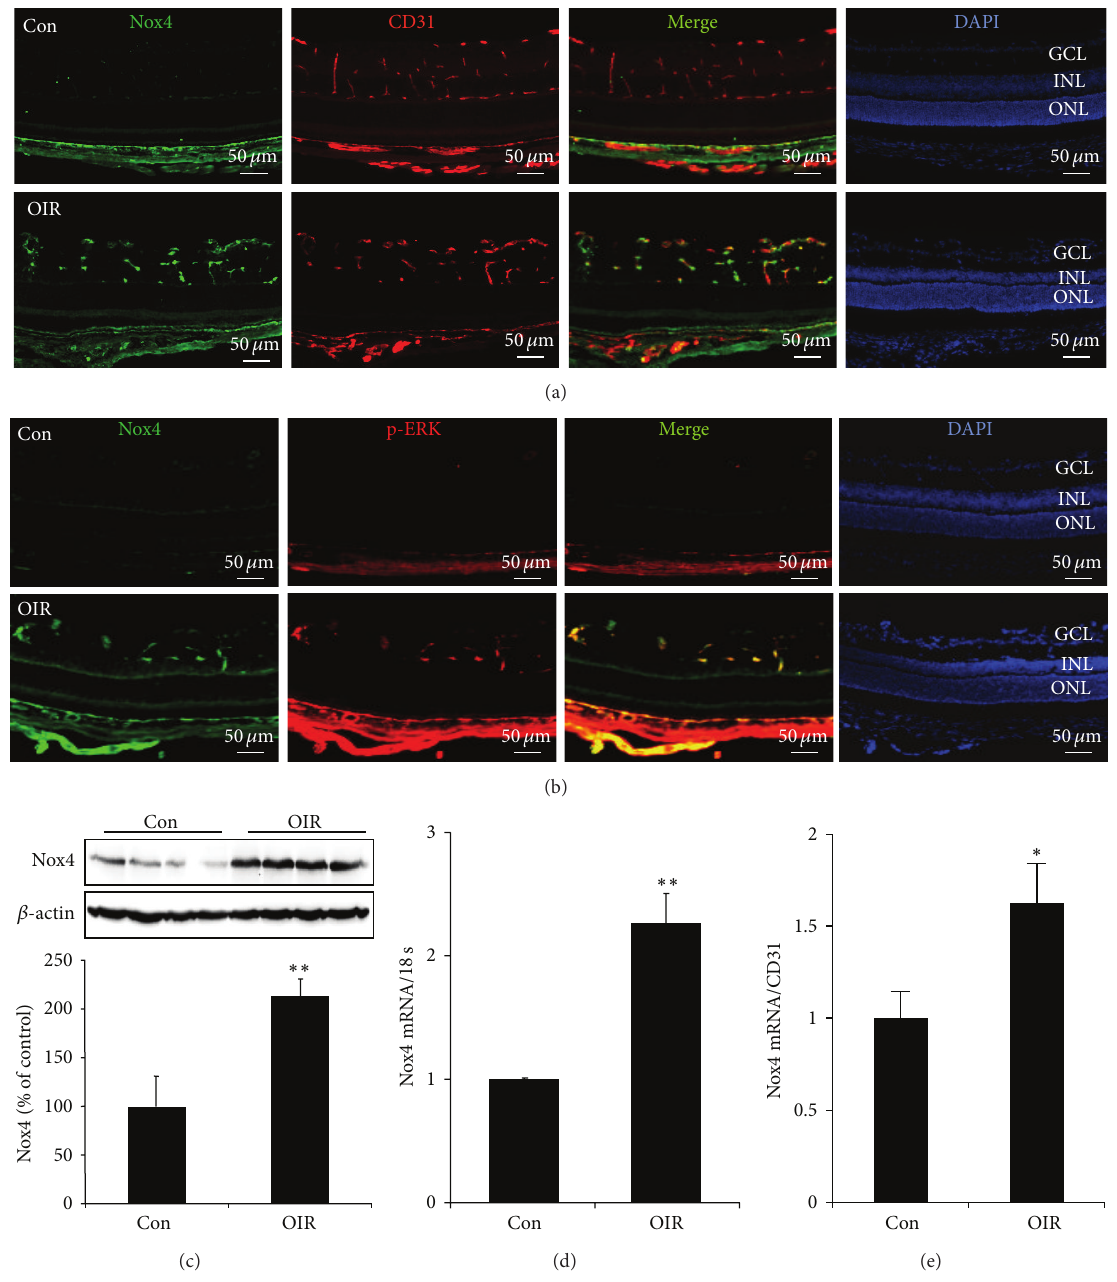
Figure 2: Nox4 expression in retinas of OIR mice at retinal NV phase. (a) Immunostaining of Nox4 (green) in retinal cryosections from P17 OIR and control mice. CD31 (red) was used to label retinal vessels. (b) Expression of phosphorylated ERK (red) and its colocalization with Nox4 (green) in the retina in P17 OIR and control mice were determined by immunostaining. (c) Expression of Nox4 protein in the retina in P15 OIR and control mice was determined by Western blot analysis and semiquantified by densitometry. 𝑛 = 4 for each group. ∗∗ 𝑃 < 0.01 versus Con. (d-e) mRNA of Nox4 in the retina in P15 OIR and control mice was measured by real-time RT-PCR and normalized to 18s (d) or to CD31 (e). 𝑛 = 4 for control group and 𝑛 = 6 for OIR group. ∗∗ 𝑃 < 0.01 versus Con.